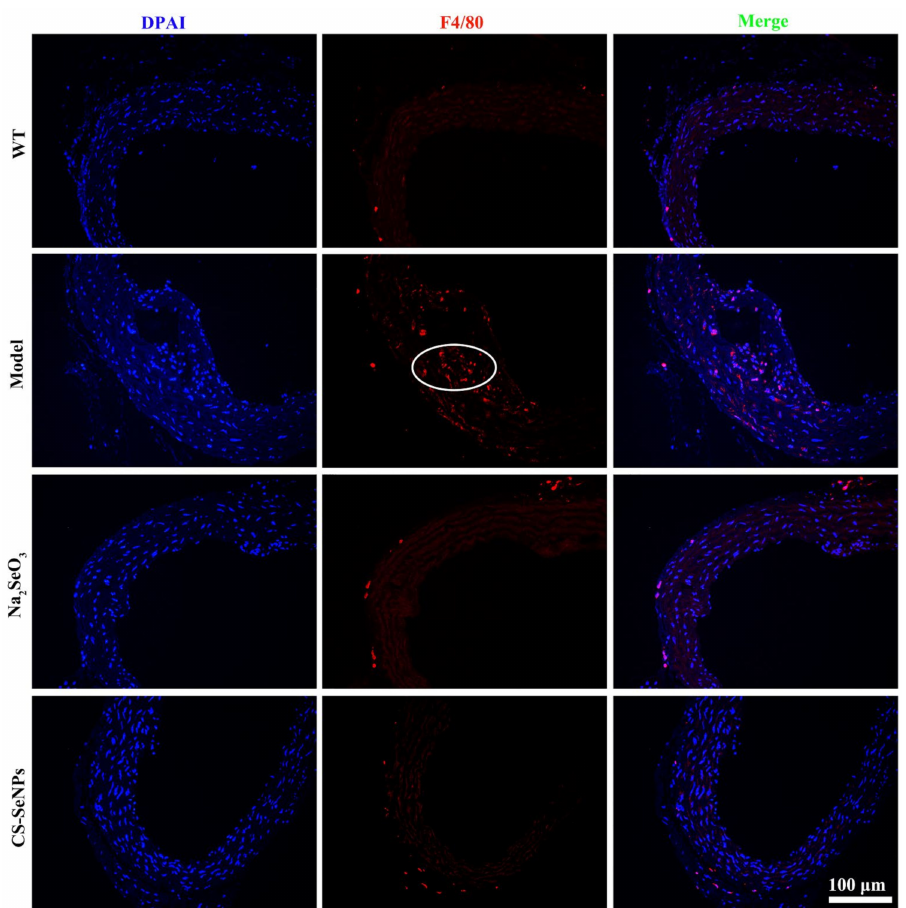
Figure 6. Immunofluorescence staining for F4/80 in aortic root tissue was performed to characterize macrophages in the aortic root. Representative images of immunofluorescence staining for F4/80 (red) in aortic root tissue (200 × ) are shown. White circles refer to F4/80-positive macrophages in